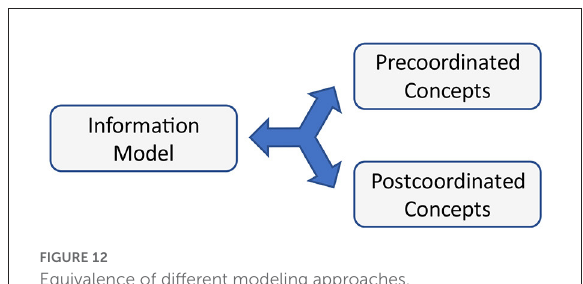
FIGURE12 Equivalence of different modeling